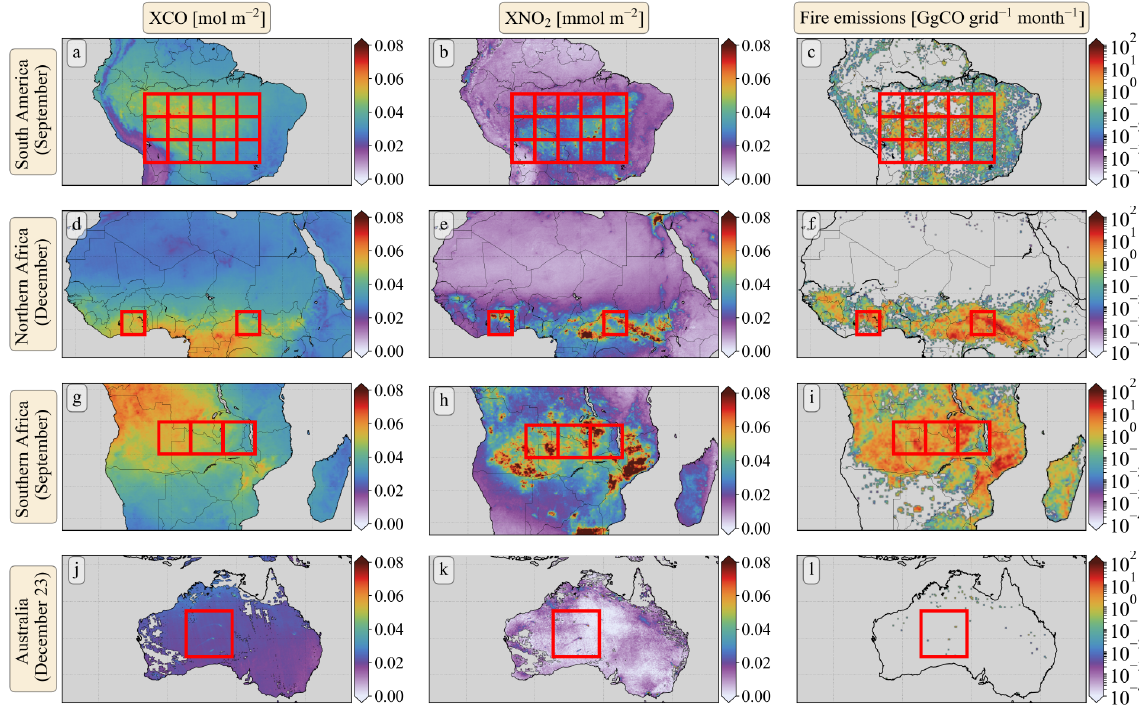
Figure 2. Maps of monthly average X CO (molm − 2 ), X NO 2 (mmolm − 2 ), and GFED4s CO emissions (GgCOgrid − 1 month − 1 ) for South America (a–c) , for northern Africa (d–f) , and for southern Africa (g–i) . Maps of daily average X CO, X NO 2 and GFED4s CO emissions are shown for Australia for 23 December 2018 (j–l) . Regions of interest are highlighted by the red